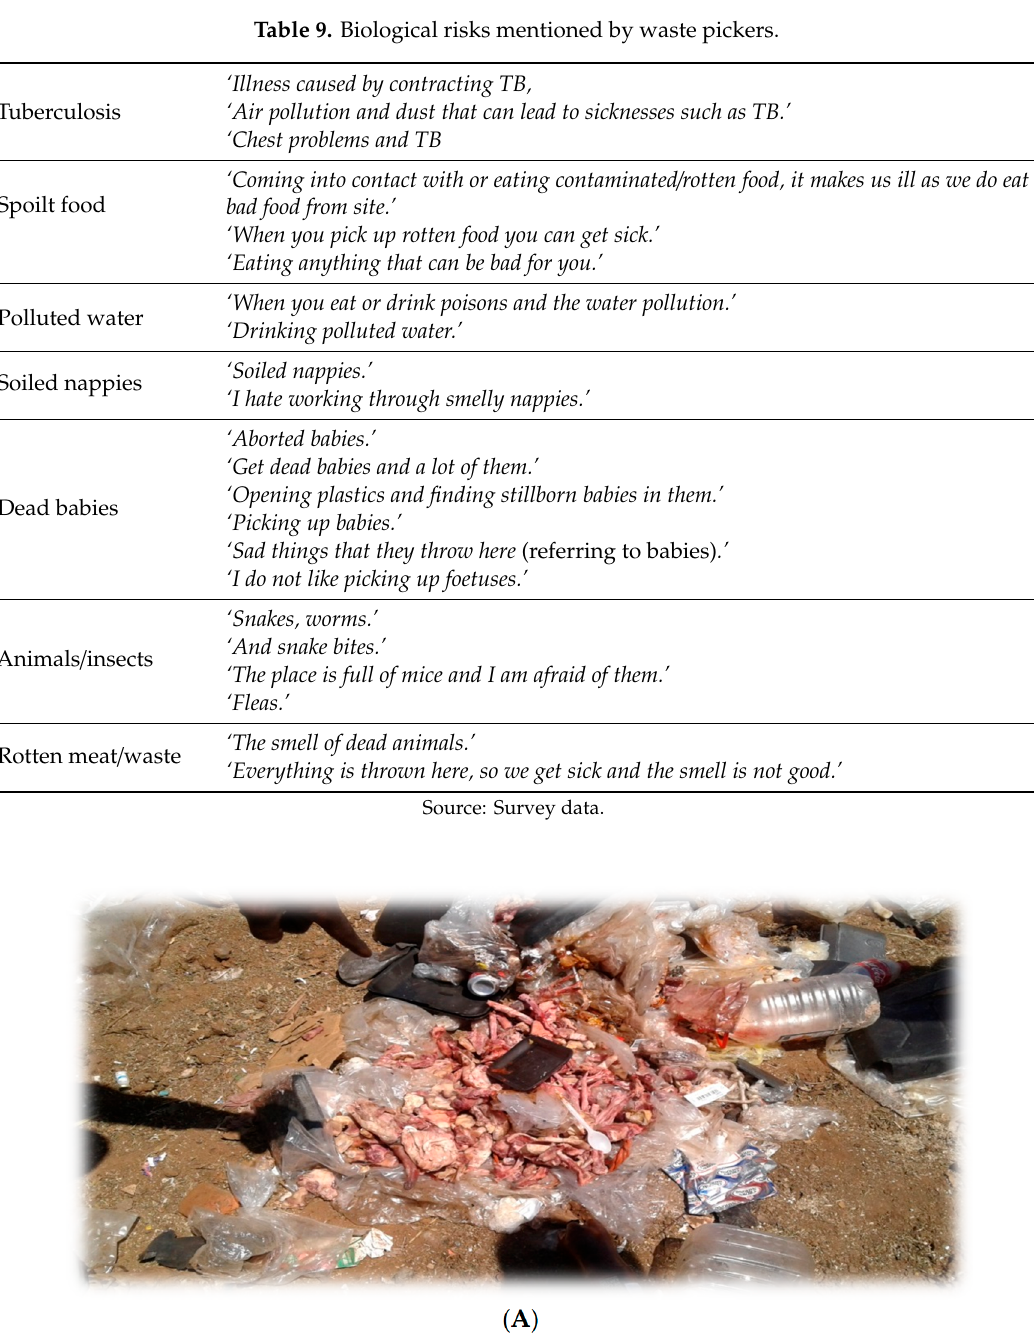
Table 9. Biological risks mentioned by waste pickers.